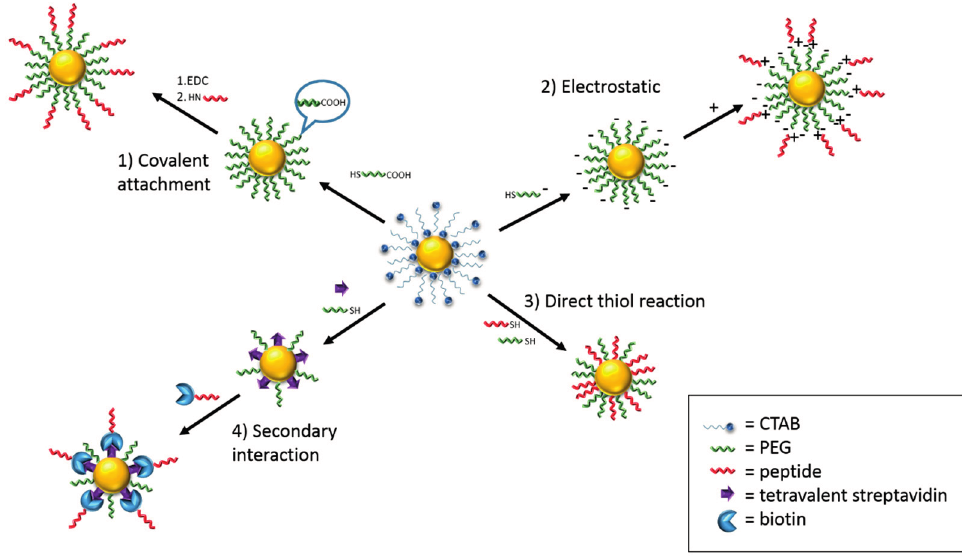
Figure 2. The four major surface modification approaches for functionalisation of nanoparticles, given a peptide as an example of a biomolecule and PEG as the antifouling